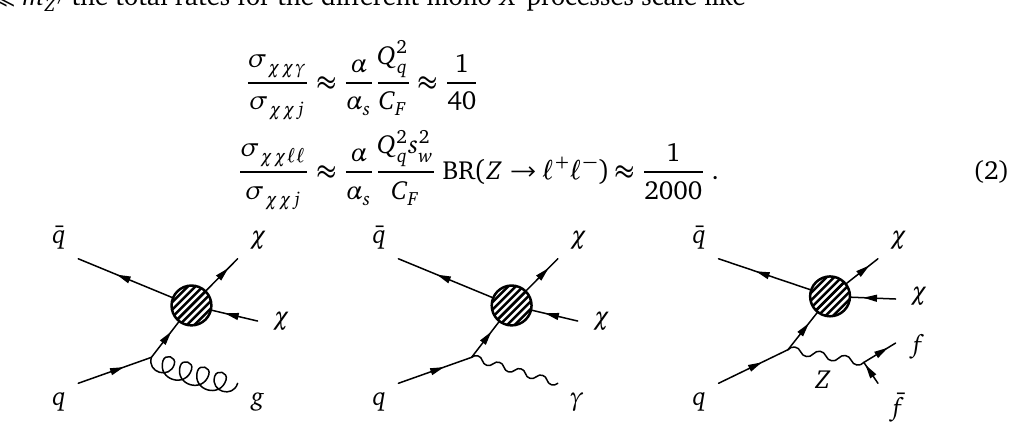
Figure 1: Feynman diagrams contributing to mono- X